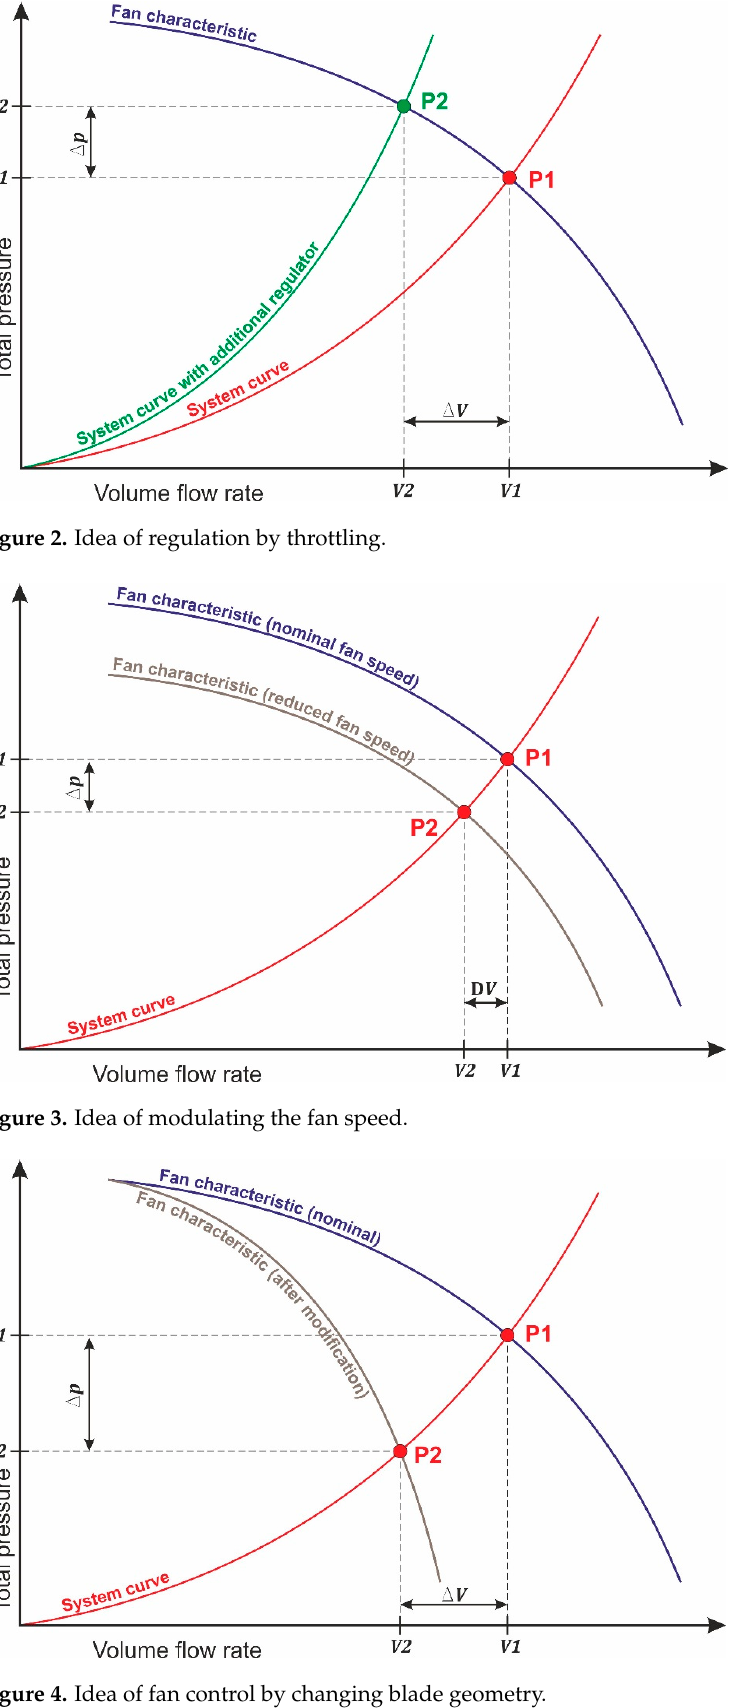
Figure 4. Idea of fan control by changing blade geometry.